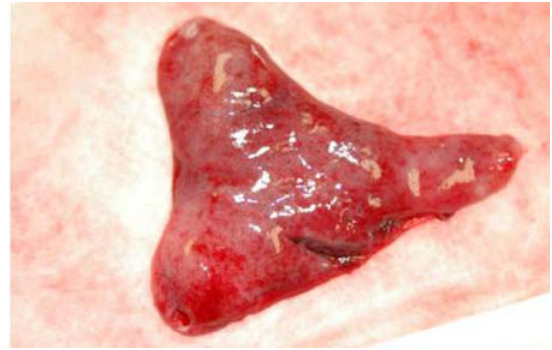
Figure 1. The uterus shaped tissue discussed in Case 1